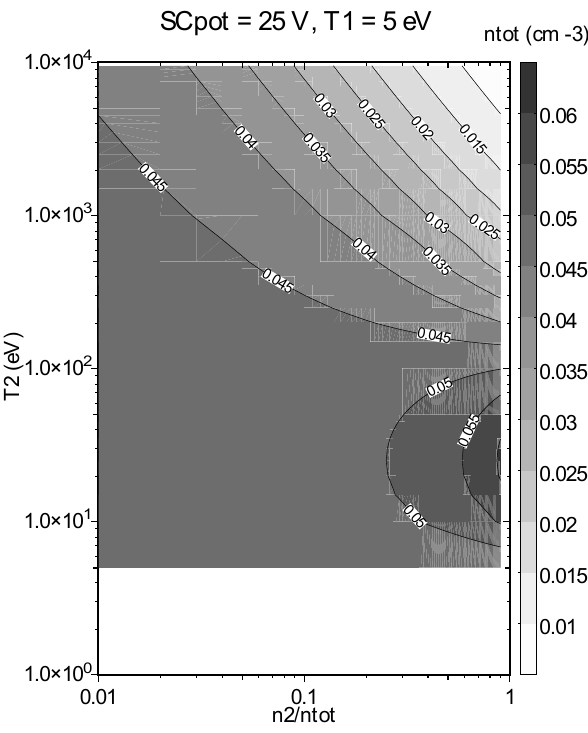
Fig. 1. Density value corresponding to a spacecraft potential − 25 V in a model containing two Maxwellian electron populations, called hot and cold. The horizontal axis is the hot versus total density ratio and the vertical axis is the hot component temperature. The cold component temperature is set to 5